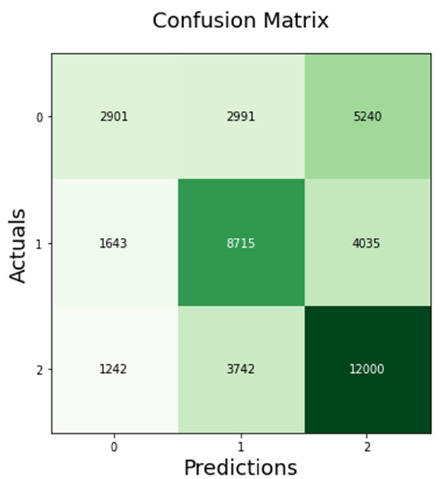
Figure 7. Word2Vec-BiLSTM confusion matrix.